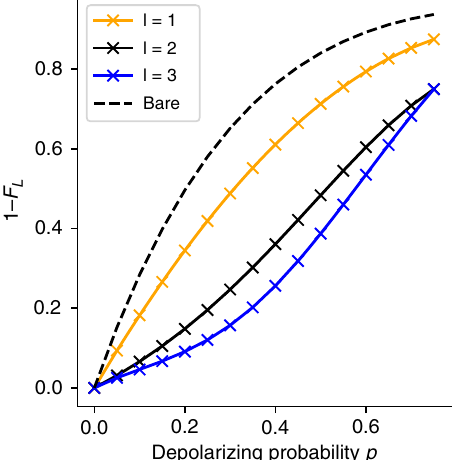
Fig. 4 Error suppression using natural molecular symmetries. Errors are plotted as a function of depolarizing probability and included projectors for an H 2 molecule at a bond length of 1.50 (cid:4) A with a physical encoding. F L here is the logical fi delity, which is the same as physical for this encoding. At this bond length, the ground state wavefunction requires considerable entanglement to be qualitatively correct. The stabilizer elements used to perform the projection here are the α - and β - number parity as well as the total X operator, which need not be an exact symmetry, given in the Jordan- Wigner encoding as S = { Z 0 Z 2 , Z 1 Z 3 , X 0 X 1 X 2 X 3 }. The depolarizing channel is applied individually to each qubit on the exact ground state. As there is no error correction encoding overhead in this case, the expected improvement over the uncorrected solution is always positive. Hence it is always advantageous in these cases where simple symmetries are known to include these measurements and corrections.